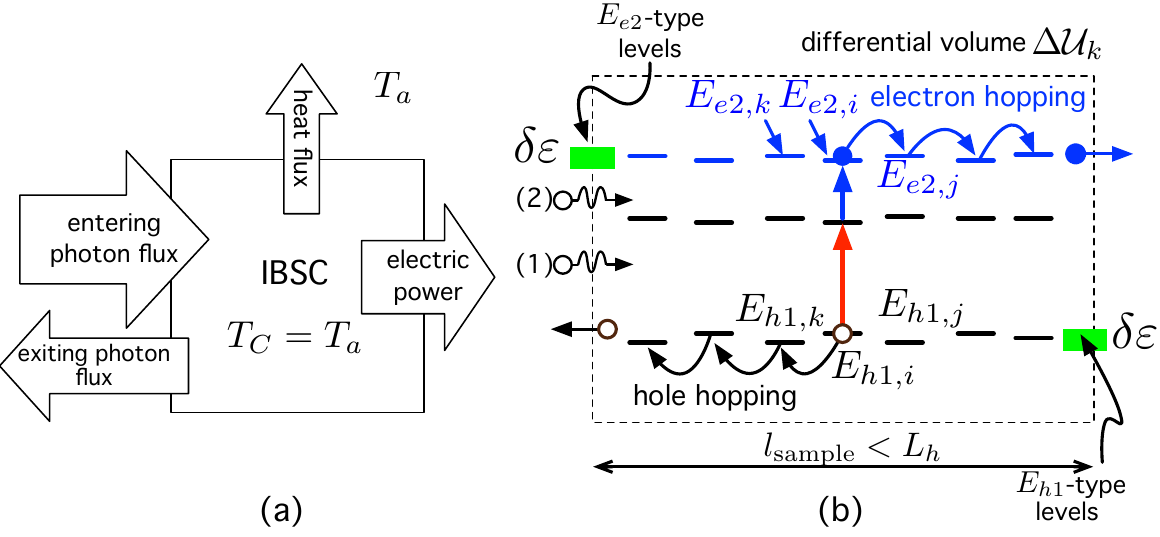
Figure 2. ( a ) The cell under illumination is an out-of-equilibrium system that absorbs (and emits) photons and partially converts their energy into electric power, a fraction being irreversible wasted in form of heat. The temperature of the cell is the same as that of the environment T C = T a . ( b ) Any of the differential volumes ∆ U k in which the cell is sub-divided. They can interchange electron/hole hopping particles and/or photons with others ∆ U m